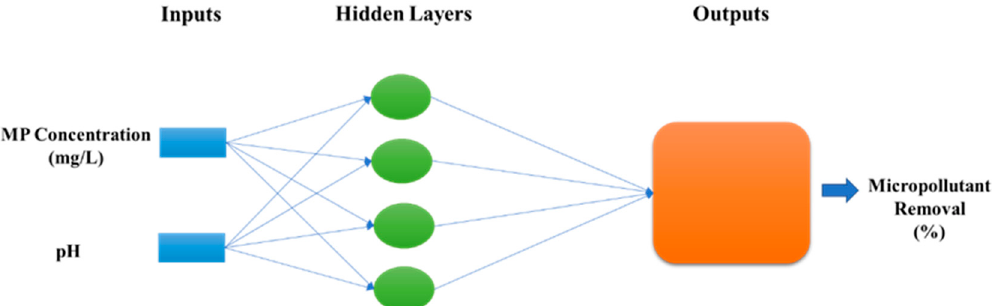
Figure 3. Schematic of an artificial neural network (ANN) design.